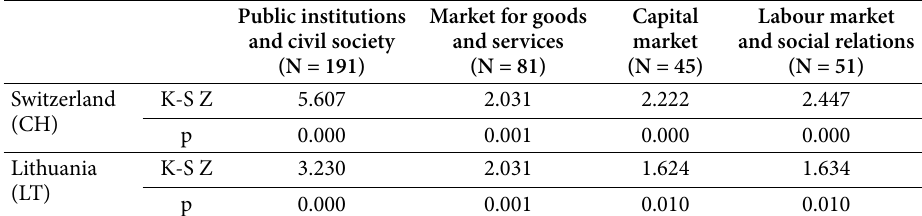
Table 1. Results of Kolmogorov-Smirnov tests